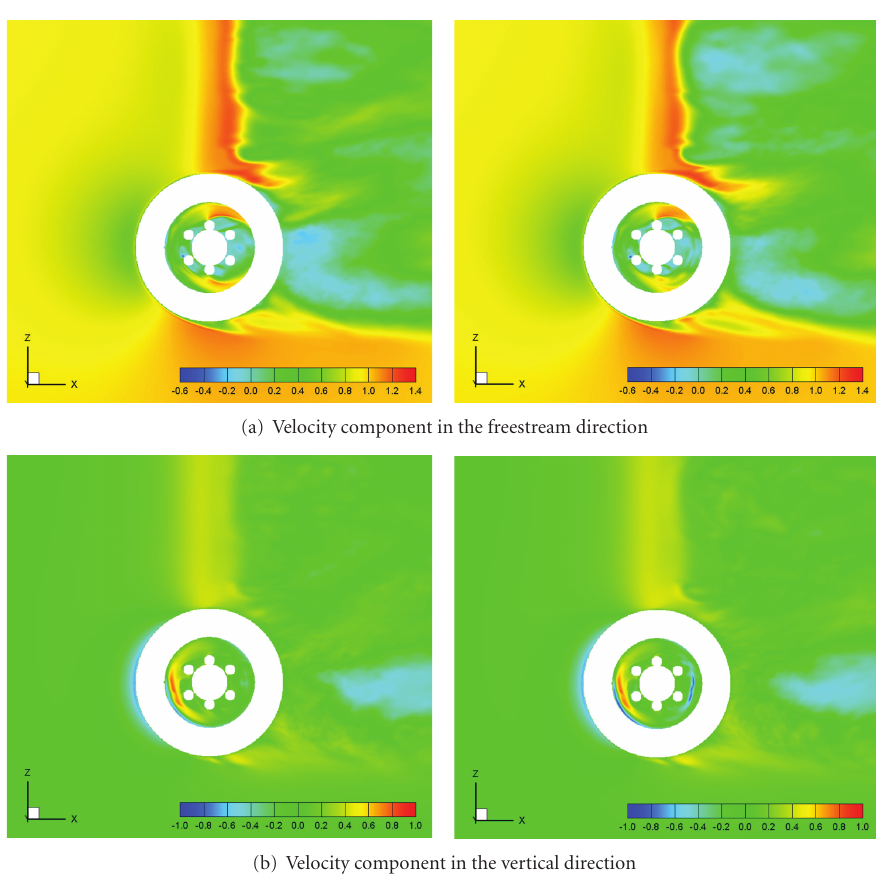
Figure 18: Computed mean velocity component in the horizontal direction at cross section y = 0 . 2 ( left: BACK TEAR, right: BACK SEAL).